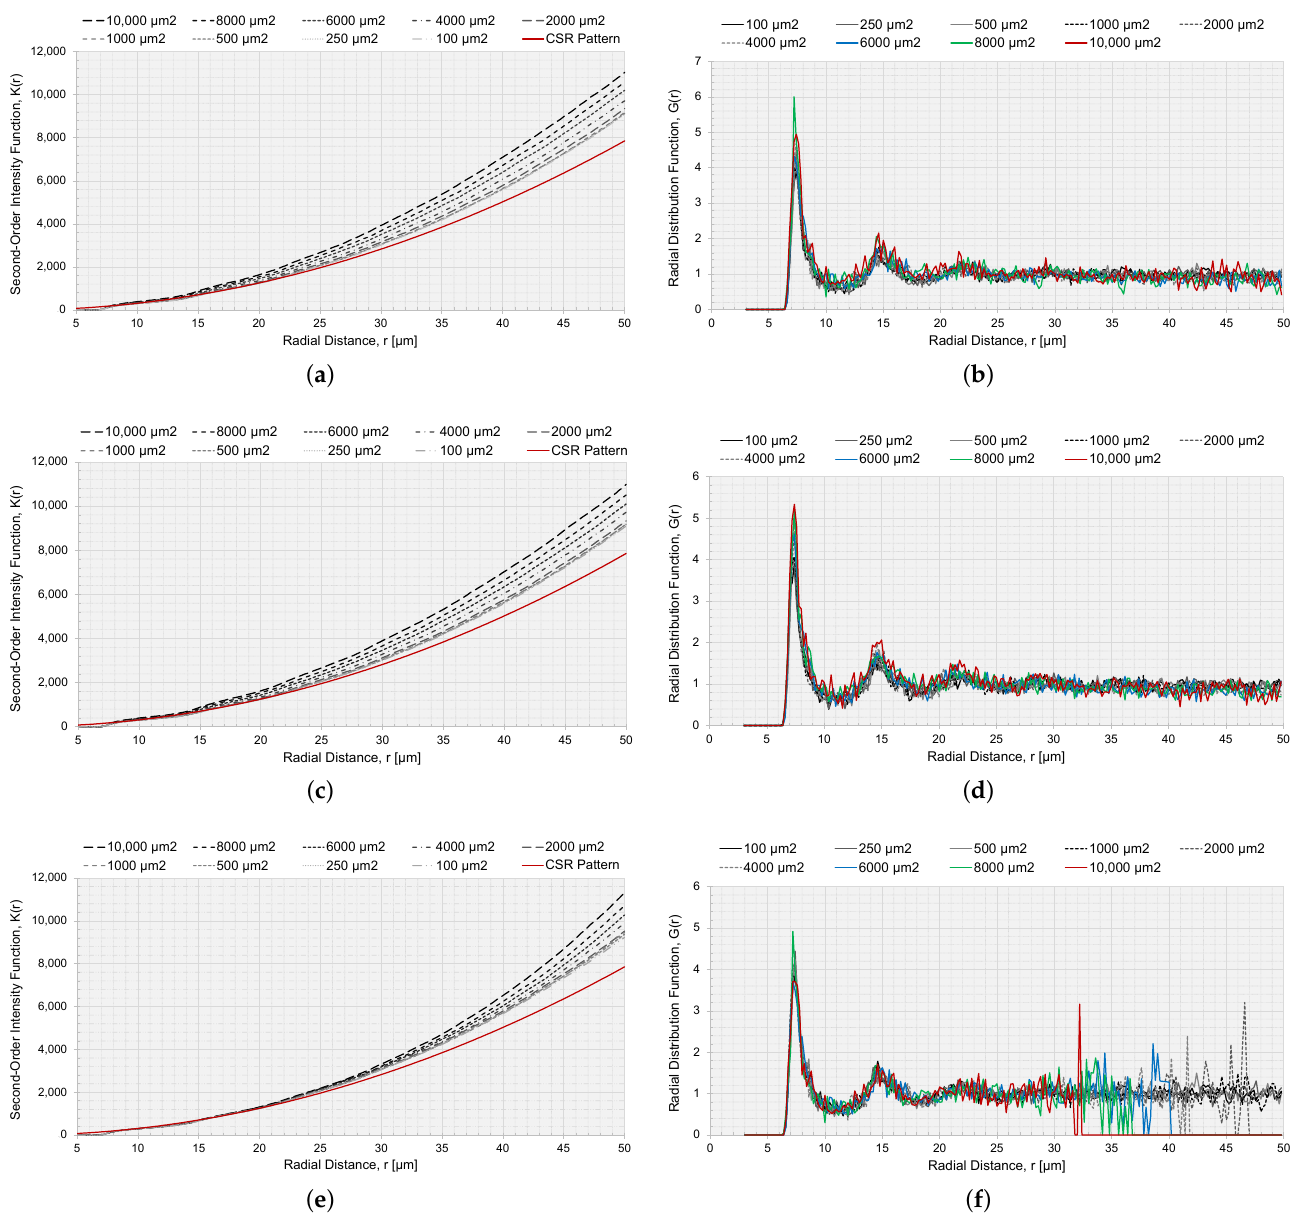
Figure 13. Second-order intensity function K ( r ) and the radial distribution function G ( r ) for RVEs with different V A . ( a ) K ( r ) with the void as a part of the observation area for circular voids, ( b ) G ( r ) with the void as a part of the observation area for circular voids ( c ) K ( r ) with the void as a part of the observation area for elliptical voids angled 0 ◦ , ( d ) G ( r ) with the void as a part of the observation area for elliptical voids angled 0 ◦ , ( e ) K ( r ) with the void not as a part of the observation area and adjusting the correction factor w k accordingly for circular voids, and ( f ) G ( r ) with the void not as a part of the observation area for circular